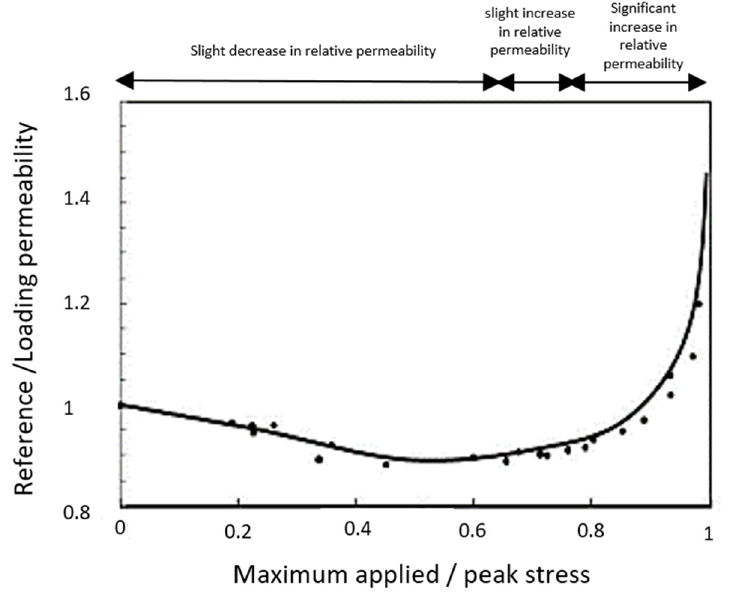
Figure 25. N 2 gas intrinsic permeability affected by loading in compression (Adapted with permission from reference [22]).